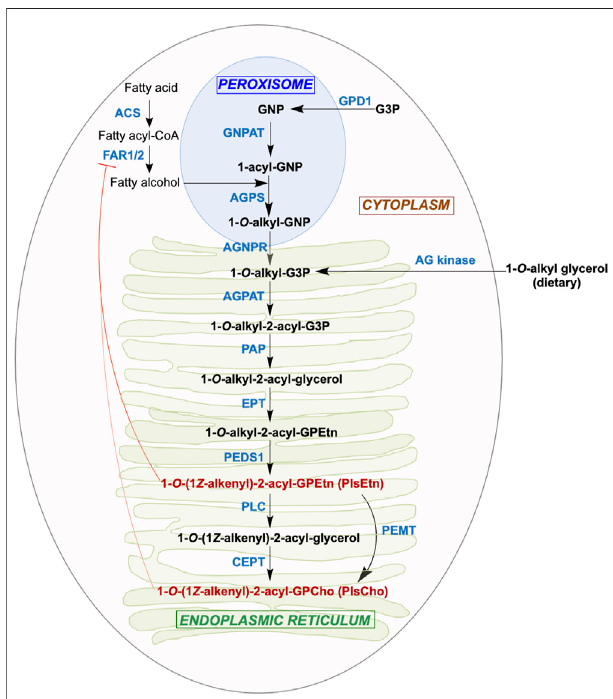
FIGURE 2 | Aerobic plasmalogen biosynthesis pathway in mammals. Synthesis of the major ethanolamine form of the plasmalogen (PlsEtn) begins in the peroxisomes and ends in the ER, followed by transport to post-Golgi compartments.Thesubstrateandproduct(blackboldface),abbreviated enzyme names (blue boldface; see text for full names and Enzyme Comission numbers),theorganellewhereeachsteptakesplace,andfeedbackregulation of FAR1 by plasmalogens (red blunt ended arrow) are